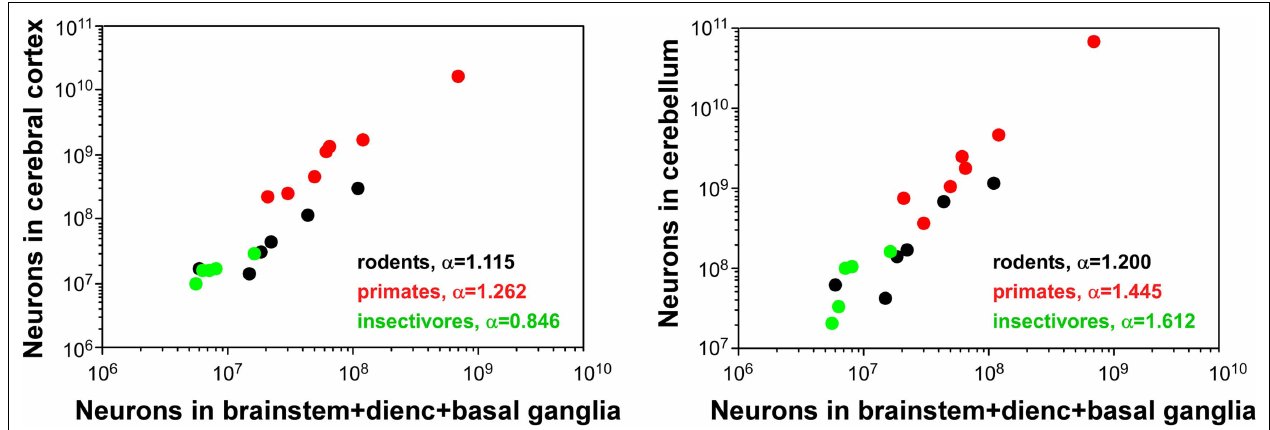
FIGURE 5 | Numbers of neurons increase faster in the cerebral cortex and cerebellum than in the remaining brain areas (the combined brainstem, diencephalon and basal ganglia). Data points indicate average values for individual species of rodents (Herculano-Houzel et al., 2006), primates (Herculano-Houzel et al., 2007 ), including humans (Azevedo et al., 2009), and insectivores (Sarko et al.,